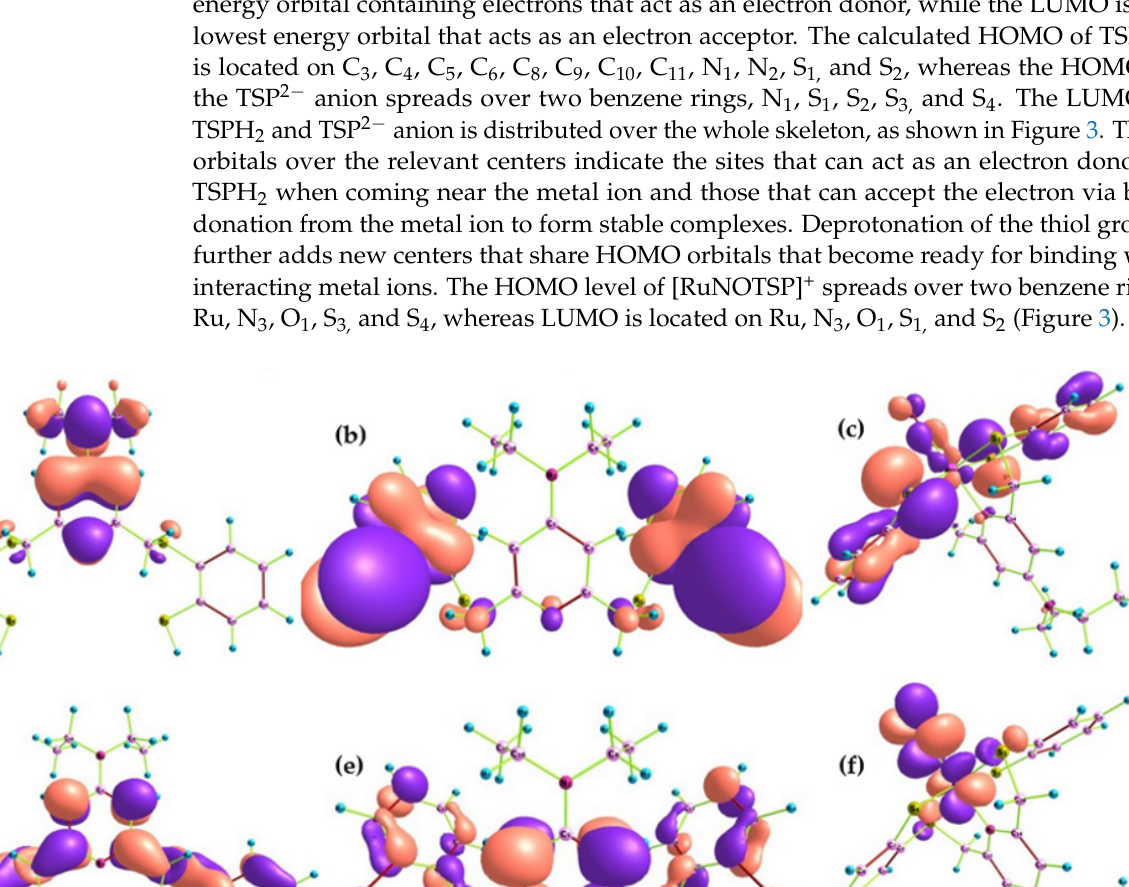
Figure 4. Molecular electrostatic potential of ( a ) TSPH 2 and ( b ) [RuNOTSP] + . 2.2. DNA Interaction Studies 2.2.1. Fluorescence Spectroscopy The most accurate and sensitive method for characterizing how drugs interact with CT-DNA is fl uorescence emission spectra [47,48]. Both [RuNOTSP] + and TSPH 2 exhibit a noticeable increase in emission when CT-DNA is added because they are both lumines- cent in the absence of DNA. Figure 5 demonstrates that increasing the concentration of